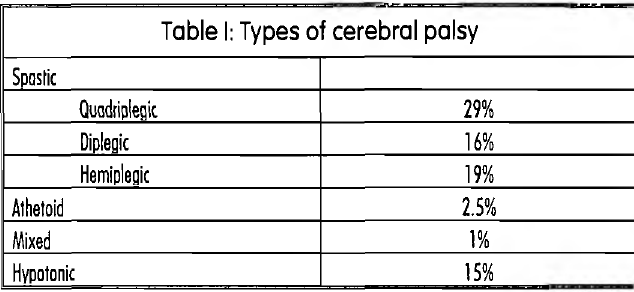
Table 1: Types of cerebral